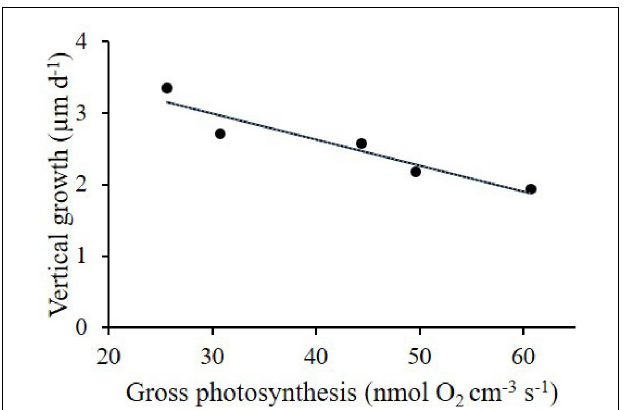
FIGURE 7 | Negative linear correlation ( R 2 = 0.89; p = 0.016) between vertical growth ( µ m d − 1 ) and gross photosynthesis (nmol O 2 cm − 3 s − 1 ) of CCA recruits grown under ambient CO 2 (CO 2 between 400.8 and 448.1 µ atm, pH 8.0–8.03) and high CO 2 (CO 2 between 998.9 and 1070.6 µ atm, pH